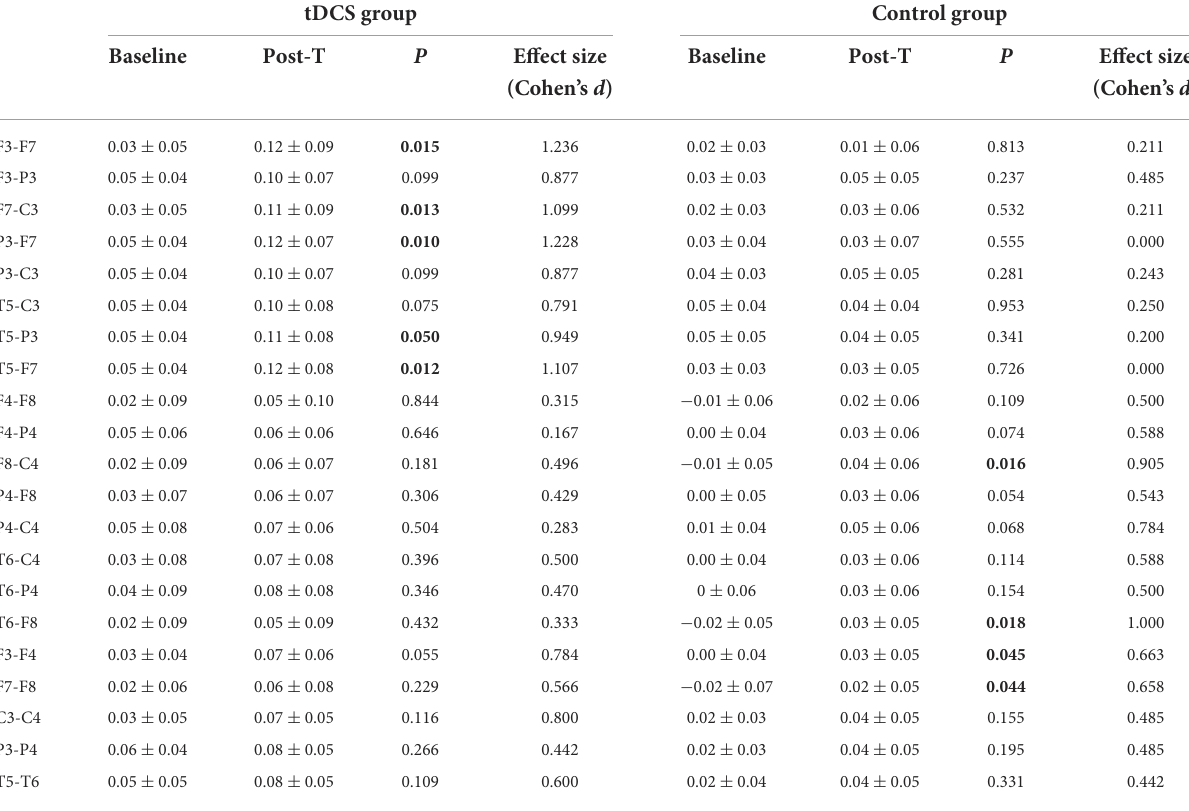
TABLE 5 The difference value of the cross-approximate entropy (C-ApEn) under the eye-closed condition and repetition task before and after the treatment. tDCS group Control group Baseline Post-T P Effect size Baseline Post-T P Effect size (Cohen’s d ) (Cohen’s d